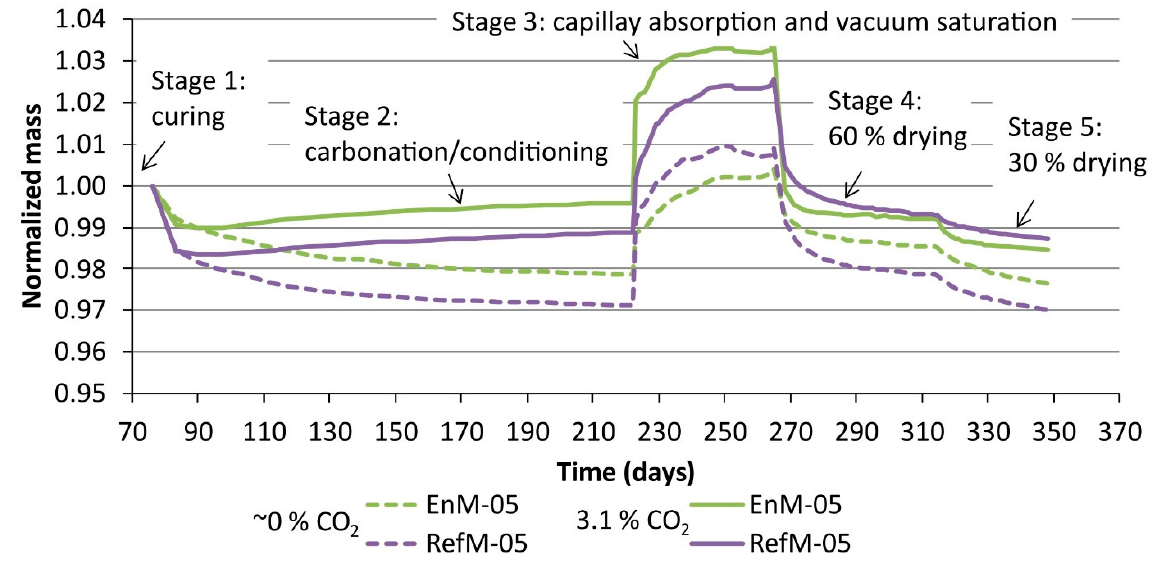
Figure 7. Mass changes during the moisture transport experiment for thin plates with a water/cement ratio of 0.5. In stage 2, group “3%” was exposed to carbonation in a 3.1% CO 2 environment and group “0%” to conditioning in a ~0% CO 2 environment. “EnM” and “RefM” stand for EnDurCrete and the reference mortar, respectively.